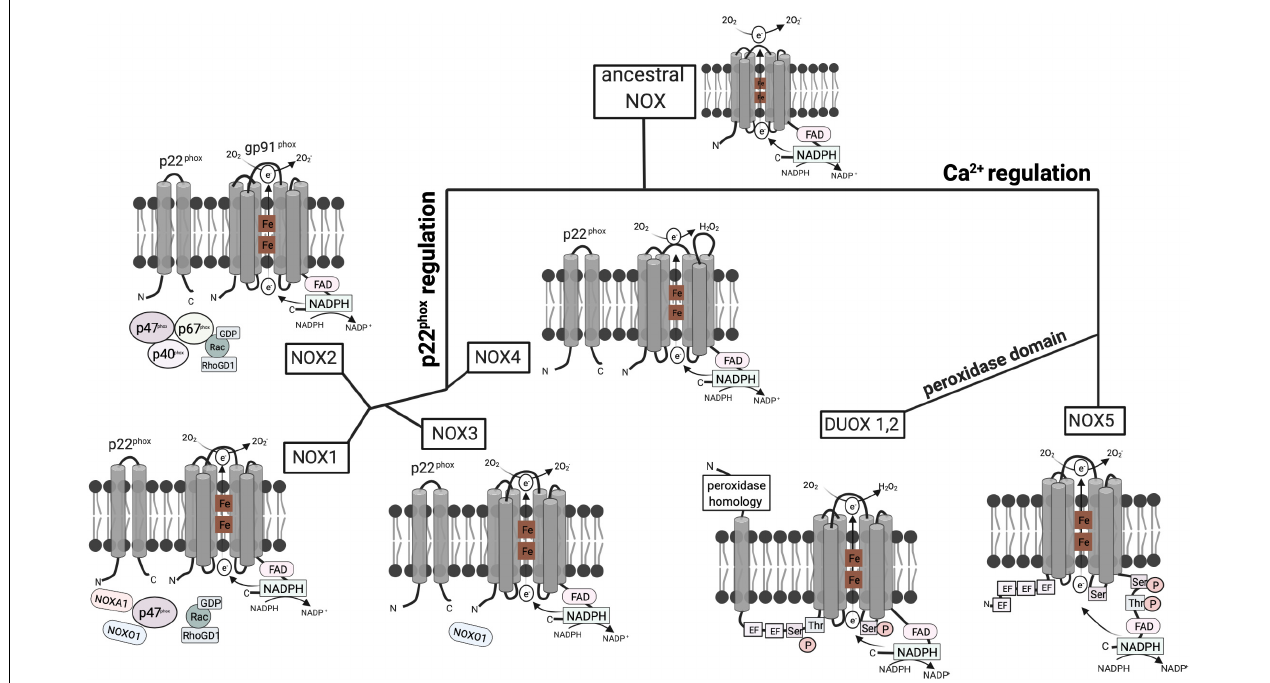
FIGURE 1 | Structure and hypothetical evolution of NOX isoforms. The ancestral NOX enzyme consists of a conserved C-terminal core region including six transmembrane a-helices, two heme (Fe) groups, and a NADPH-binding cytoplasmic C-terminal domain. The conserved gp91 phox subunit transfers electrons from NADPH to reduce oxygen (O 2 ) to superoxide anion (O 2 − ). Later NOX isoforms acquired dependence on the activating subunit p22 phox or calcium. NOX1–3 and NOX4 emerged from a common branch, as both of these subgroups depend on the presence of the p22 phox subunit with two transmembrane a-helices. However, NOX4 solely relies on p22 phox , while NOX1–3 require additional cytoplasmic subunits. Mammalian NOX2 additionally relies on the cytoplasmic regulators p47 phox , p67 phox , p40 phox , and Rac. In contrast, NOX1 is regulated by NOXO1 and NOXA1. NOXO1 also contributes to NOX3 activation. NOX5 evolved from ancestral NOX through the acquisition of four EF hand motifs containing a Ca 2 + -binding domain, which enables activation by cytosolic calcium rather than other subunits. DUOX1/2 enzymes then emerged from NOX5 isoforms by the addition of a peroxidase domain in the N-terminal region enabling H 2 O 2 production (Bedard et al., 2007; Kawahara et al.,